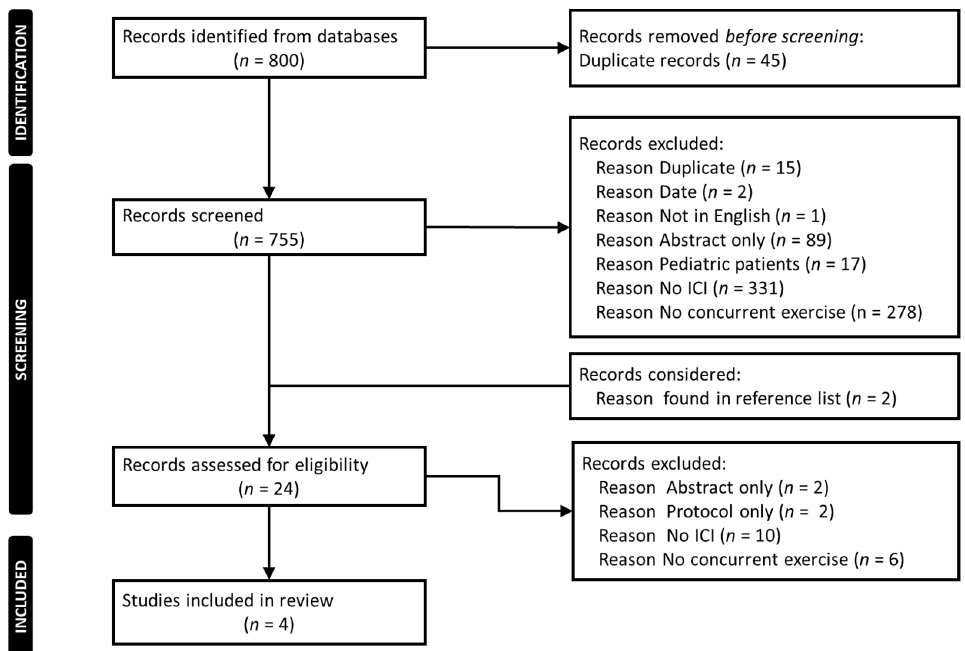
Figure 1. PRISMA Flow Chart of Studies included in the review.